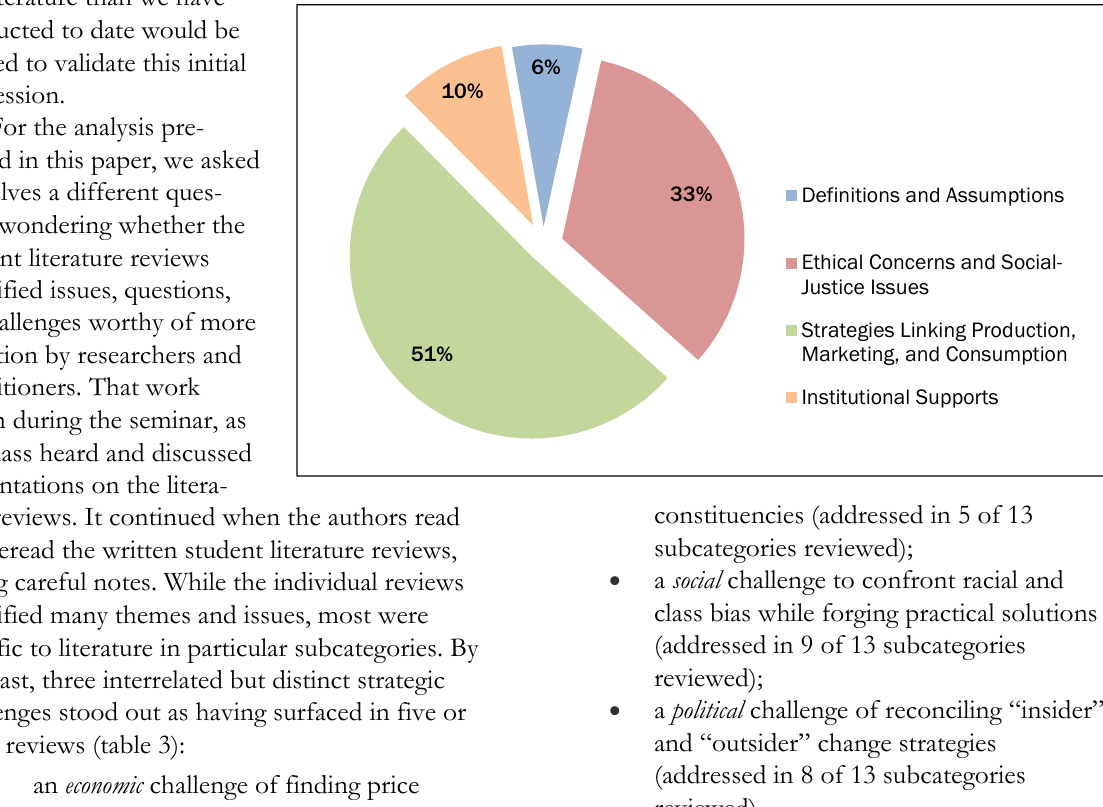
Figure 1. Of the 501 Articles Reviewed for This Paper, the Percentage That Came from Each of the Four Main Categories of the Bibliography